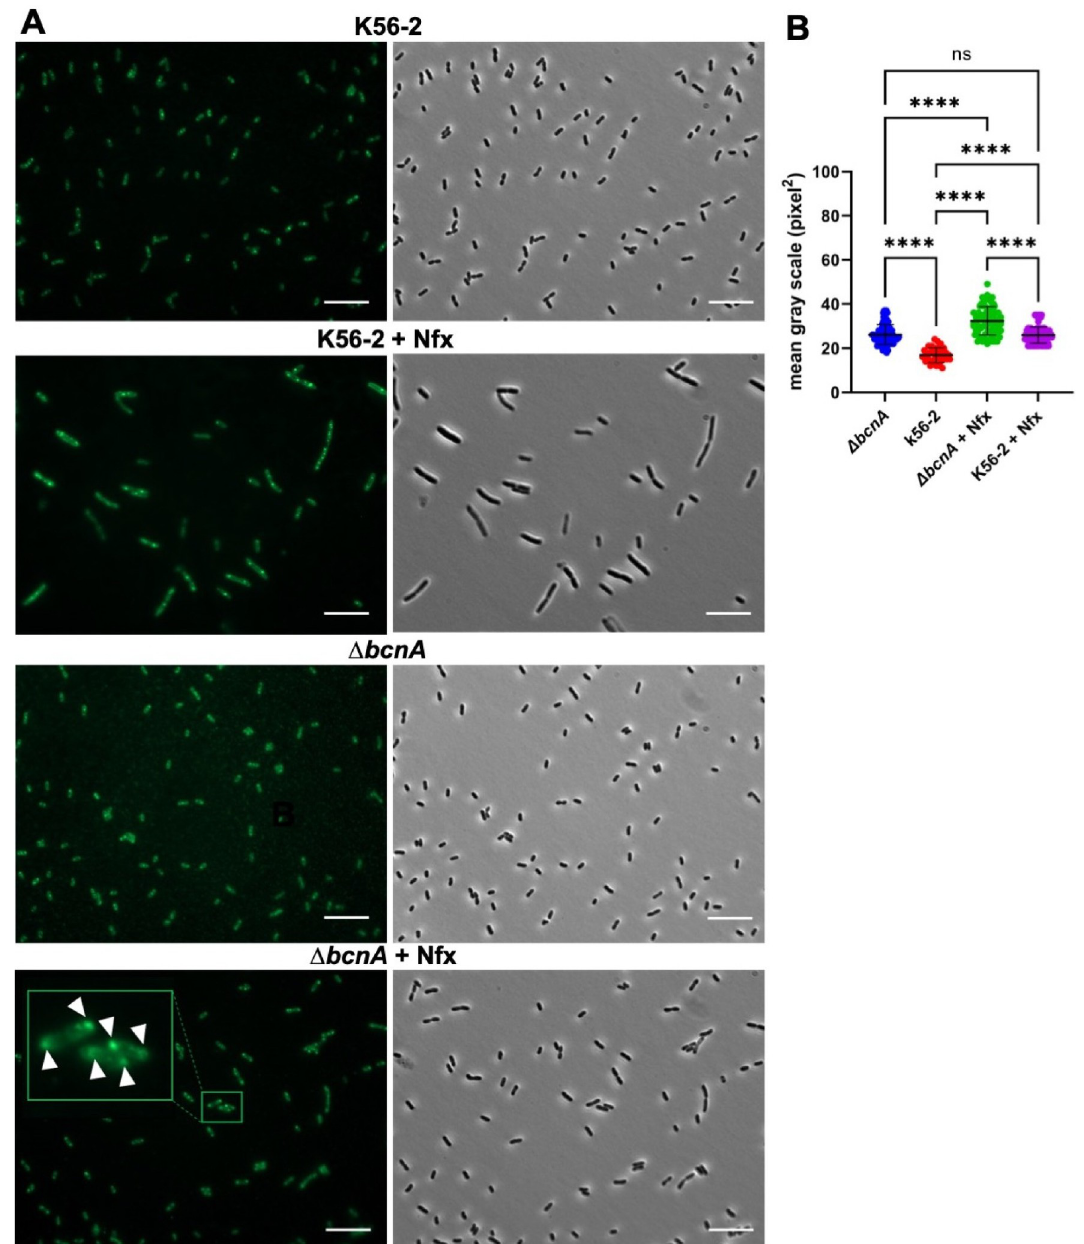
Fig 3. Detection of lipid peroxidation in Δ bcnA by fluorescence microscopy using NBD-Pen. (A) Fluorescence (left) and phase contrast (right) images of Δ bcnA and K56-2 strains untreated or treated with 75% MIC for norfloxacin (Nfx) and incubated with NBD-Pen. The insets are zoomed sections of the images to provide more detail of the location of the fluorescent at the cell poles and mid cell (arrowheads). Scale bars, 10 μ m. (B) Quantitative analysis of fluorescence intensity based on fluorescence images in panel A. SD shown as error bars, and mean values shown as horizontal black lines. Statistical significance was determined by 1-way ANOVA with Tukey multiple comparisons test post hoc analysis. ���� , p < 0.0001; ns, nonsignificant. Data underlying the graphs in this figure can be found in S2 Data. MIC, minimum inhibitory concentration; NBD-Pen, 2,2,6-trimethyl-4-(4-nitrobenzo [1,2,5]oxadiazol- 7-ylamino)-6-pentylpiperidine-1-oxyl; SD, standard deviation.